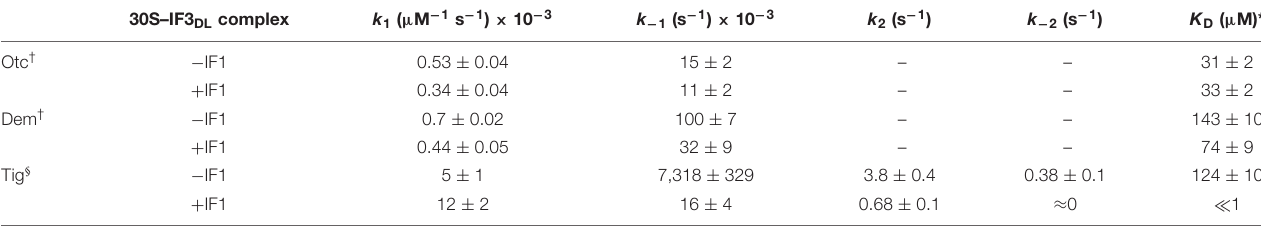
TABLE 1 | Summary of rate constants of IF3 conformational changes during binding of Tetracyclines to 30S subunit. 30S–IF3 DL